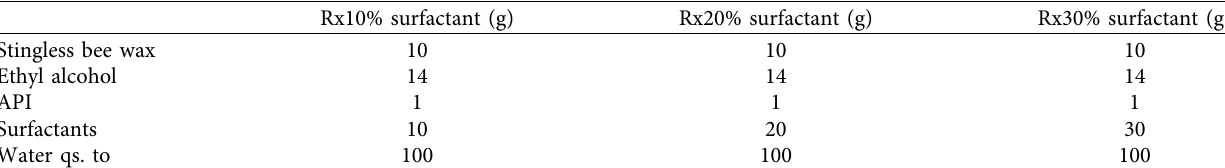
Table 1: Formulation